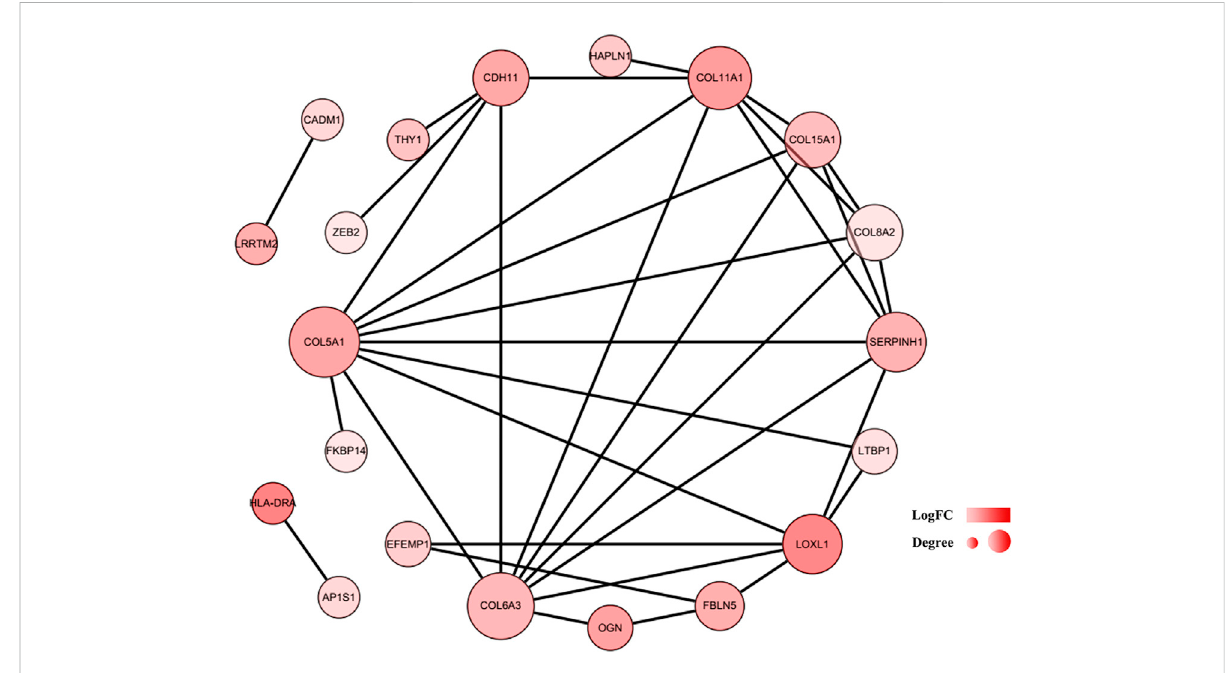
FIGURE 6 PPI network of 37 mRNAs. The color of a node in the PPI network re fl ects the log (FC) value of gene expression, and the size of node indicates the number of interacting proteins with the designated protein.